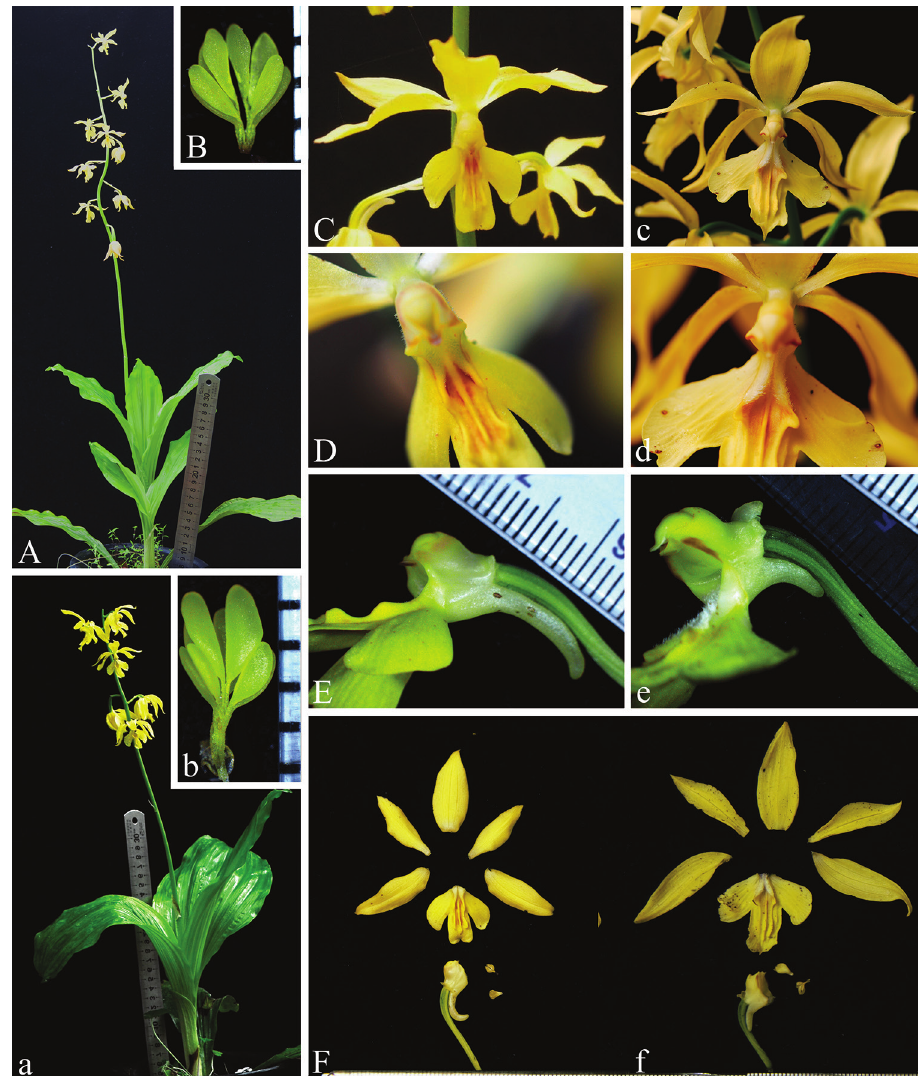
Figure 1. Morphological comparison between Calanthe sieboldopsis B.Y.Yang & Bo Li, sp. nov. ( A–F ) and C. sieboldii Decne. ex Regel ( a–f ) A, a habit B, b pollinia C, c flowers D, d column (top view) and base of lips E, e column (lateral view) and spur F, f dissection of a